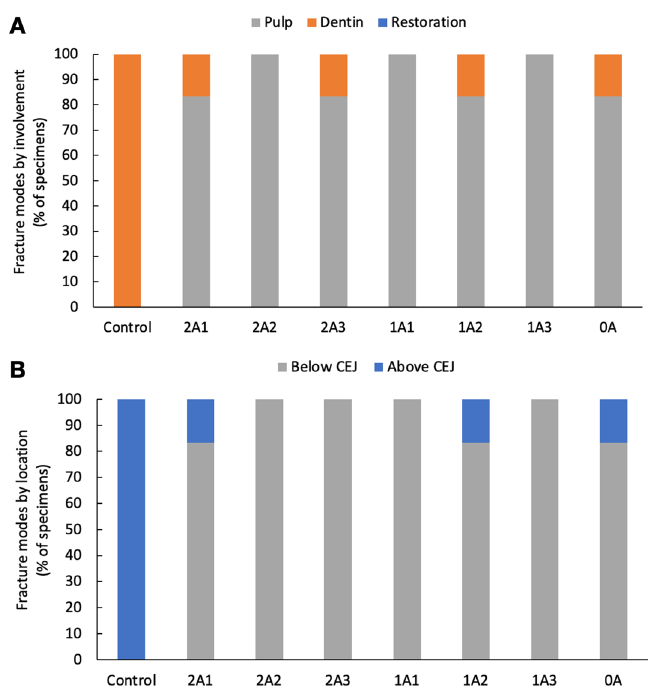
Figure 5. The fracture mode of the control group and the variously designed overlay groups according to ( A ) involvement and ( B ) location above or below the